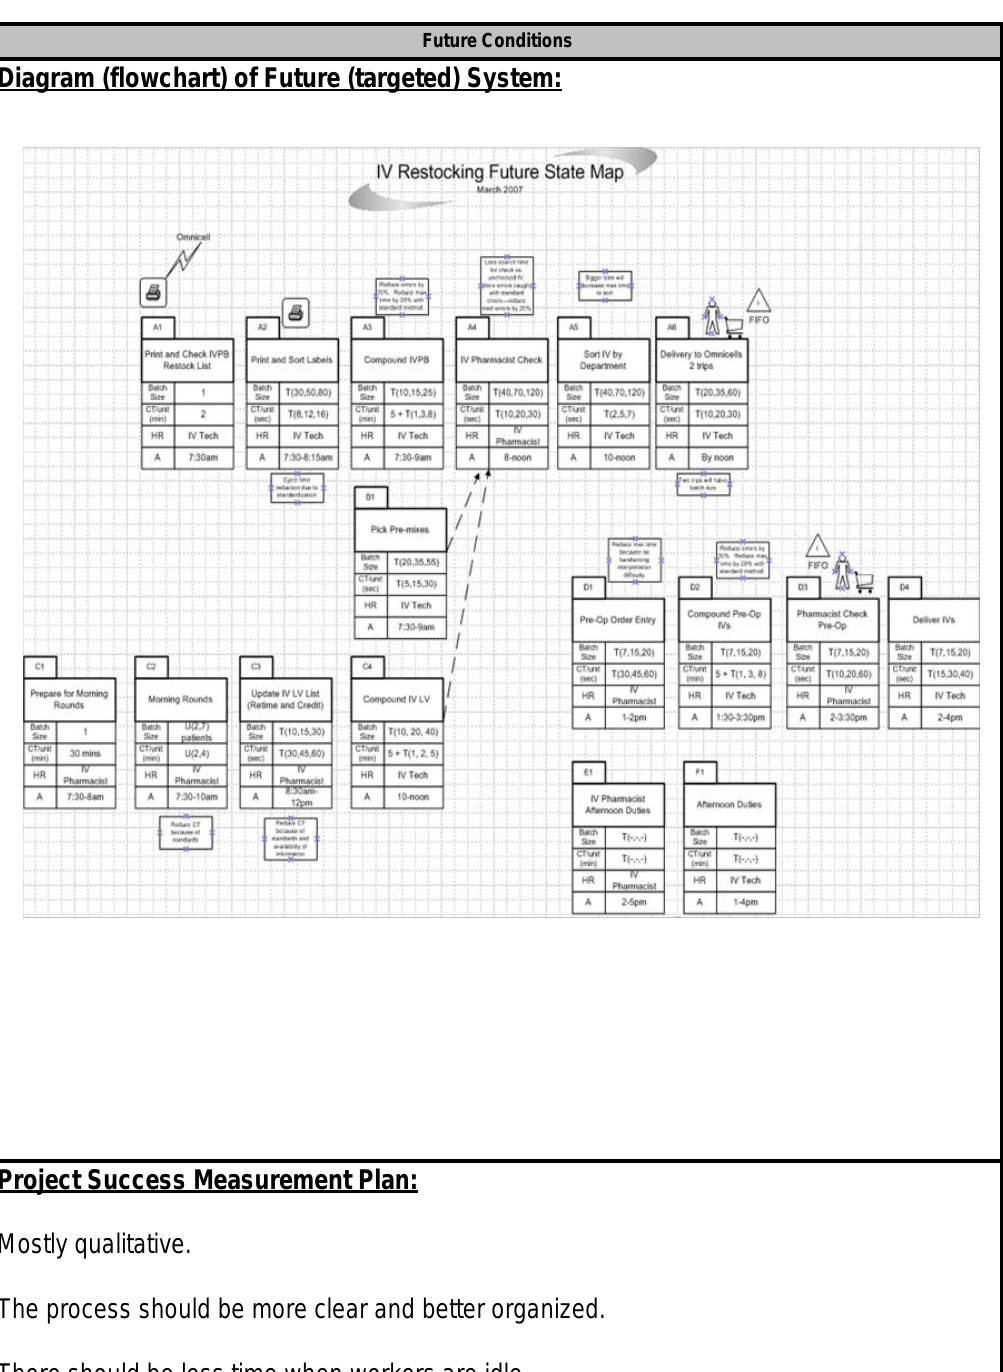
Figure 1c. “Map to Improve (M2I) Tool: Page